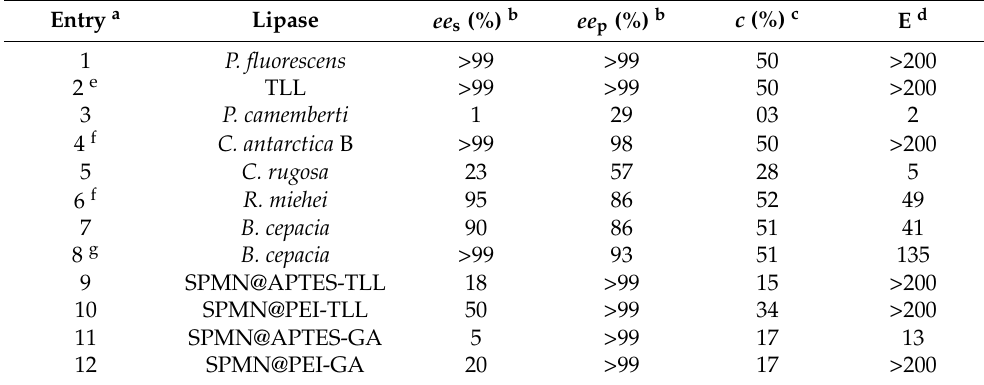
Table 1. Screening of lipases in the kinetic resolution of rac - 5a via hydrolytic approach. Entry a